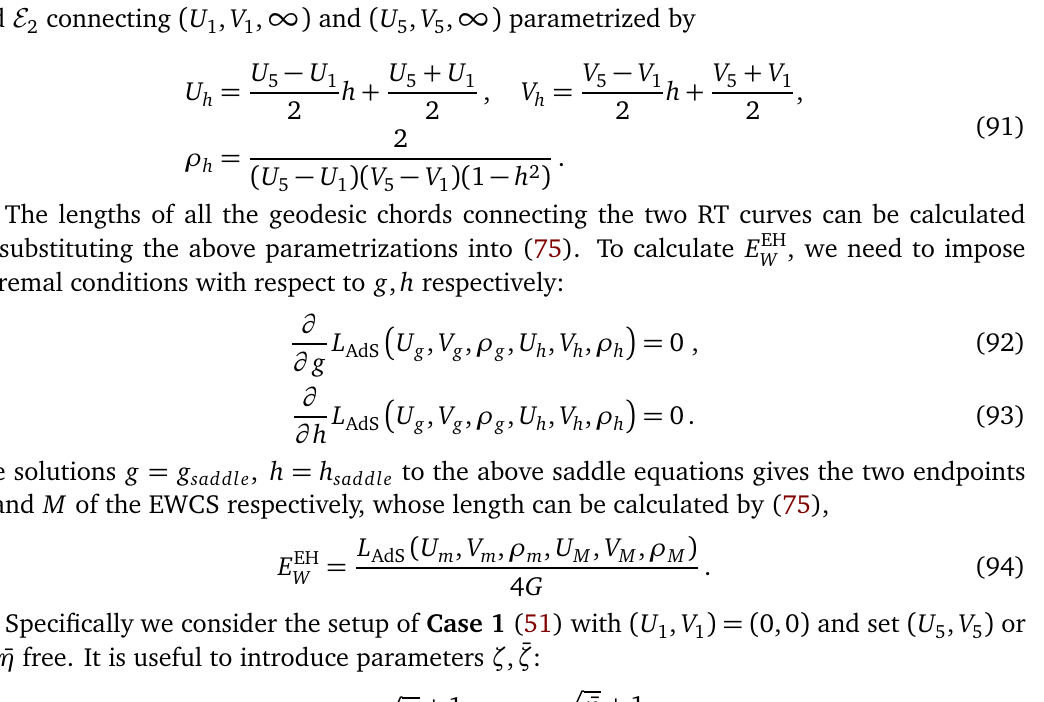
= E ∪ E . The vectors n AB 1 2